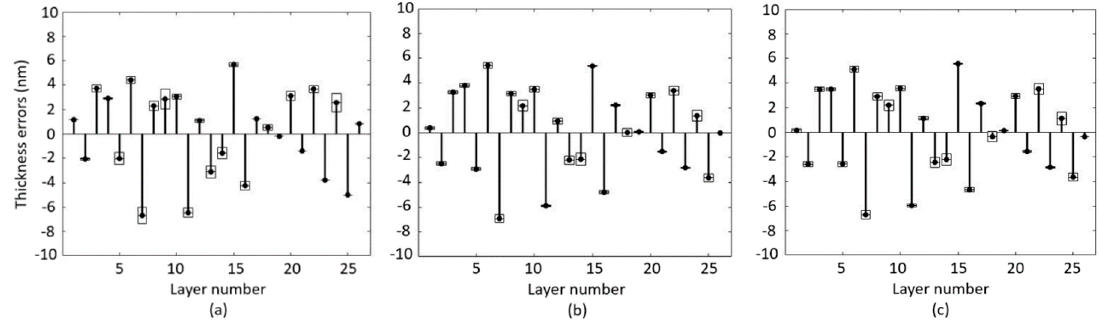
Figure 2. Average values of thickness errors and fluctuations of thickness errors found by the modified S-algorithm ( a ); modified T-algorithm ( b ); and T-algorithm ( c ).